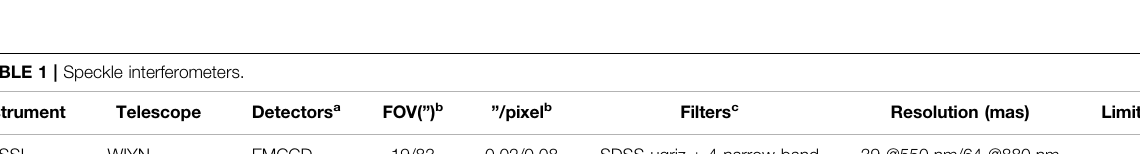
FIGURE5|(Left) OneofthetwoidenticalspeckleimagersunderconstructionattheNASAAmesResearchCenter.Thetwogreyboxesextendingoutoftheblack box are the two Andor EMCCD cameras. (Middle) A close-up view of the instrument mounted on Gemini at the GCAL port and (Right) a view of the instrument (black box) with the associated power supply, electronics, and computer unit (white box). See yellow arrows.